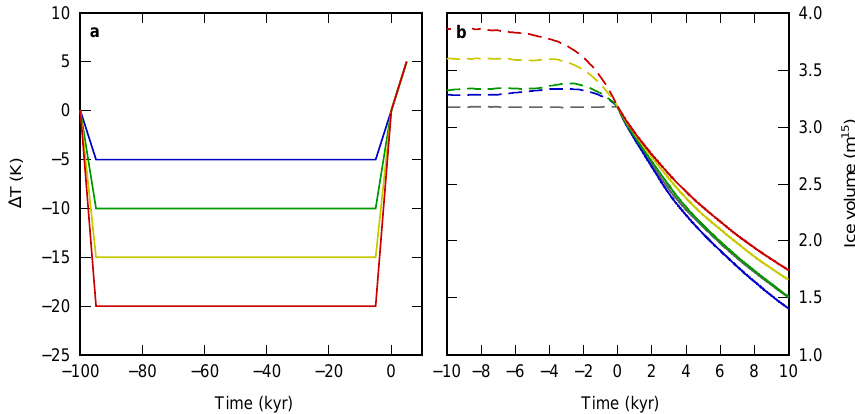
Fig. 3. The dependence of ice sheet sensitivity to their temperature history: (a) schematic temperature forcings and (b) resulting ice sheet volume evolution. Dashed lines in (b) are the ice sheet volume response of the different forcings from (a) . Each of these simulation is continued until the ice volume of the steady-state ice sheet (grey dashed line) is reached. Results in (b) are horizontally shifted such that they have identical ice volume at t =0. After t =0, all simulations are forced with the same Eemian climatology from Van de Berg et al. (2011) for 10kyr.